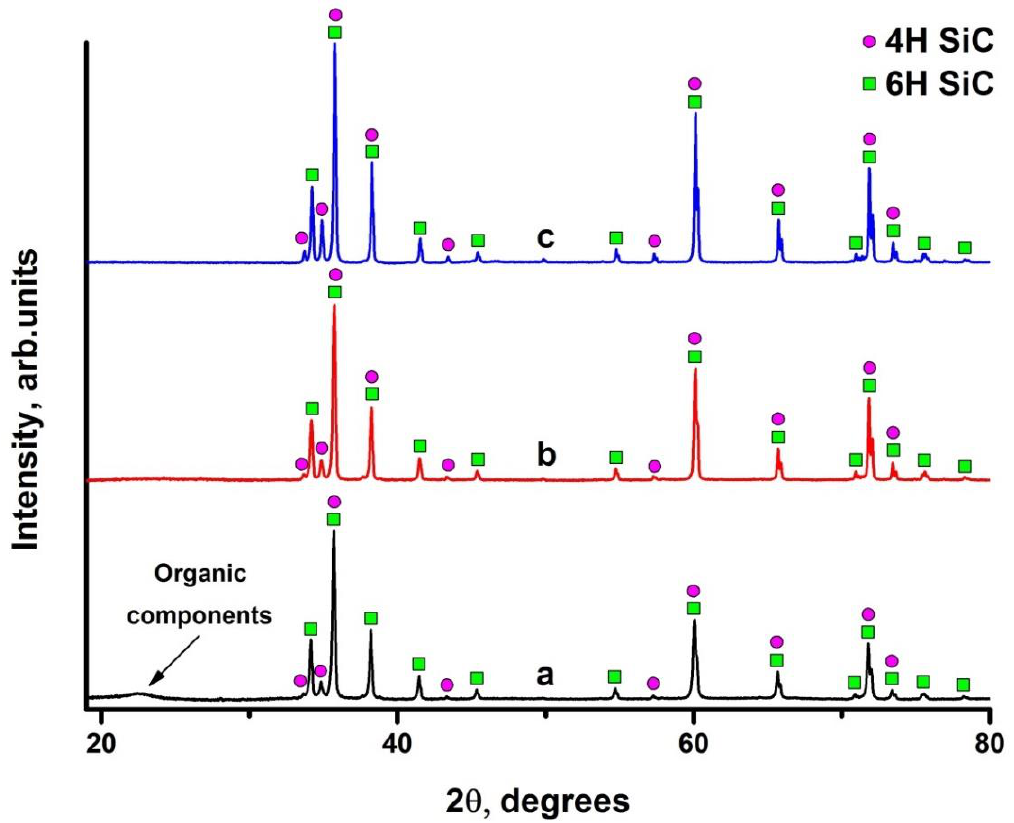
Figure 10. Diffraction patterns of preceramic paper ( a ); preceramic papers-derived SiC ( b ) and SiC f /SiC p composite ( c ).